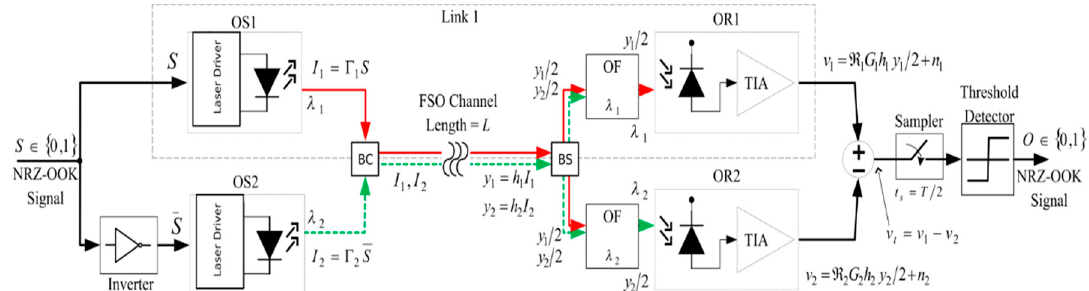
Figure 1. A schematic block diagram of differential signalling scheme (DSS). The labels OS, BC, BS, OR, OF, and TIA are optical source, beam combiner, beam splitter, optical Rx, optical filter, and transimpedance amplifier, respectively. T is the bit